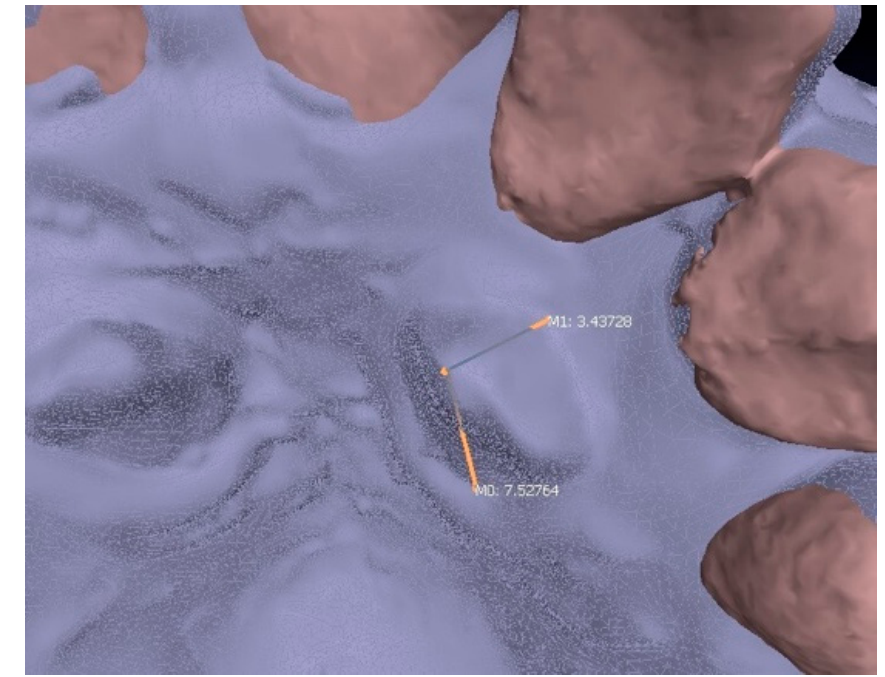
Figure 5. Measurement of the maximum palatal and vestibular length.